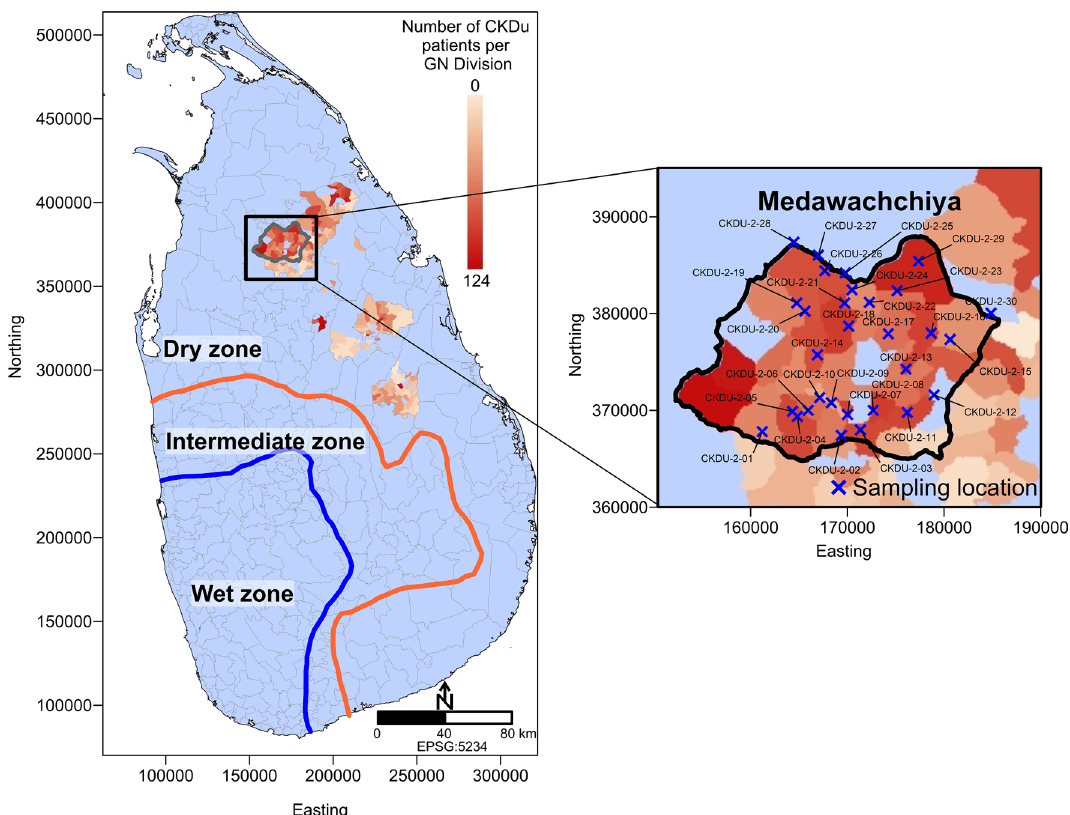
Figure 1. Sri Lanka map showing dry (< 1750 mm year −1 ), intermediate (1750–2500 mm year −1 ) and wet (> 2500 mm year −1 ) zones. Inset shows the study region in Medawachchiya with groundwater sampling locations shown as blue crosses. CKDu prevalence represents numbers of CKDu patients in each Grama Niladhari (GN) Division, showing high prevalence within the dry zone. Figure prepared in Surfer v.11.0.642 (www. golde nsoft ware. com/ produ cts/